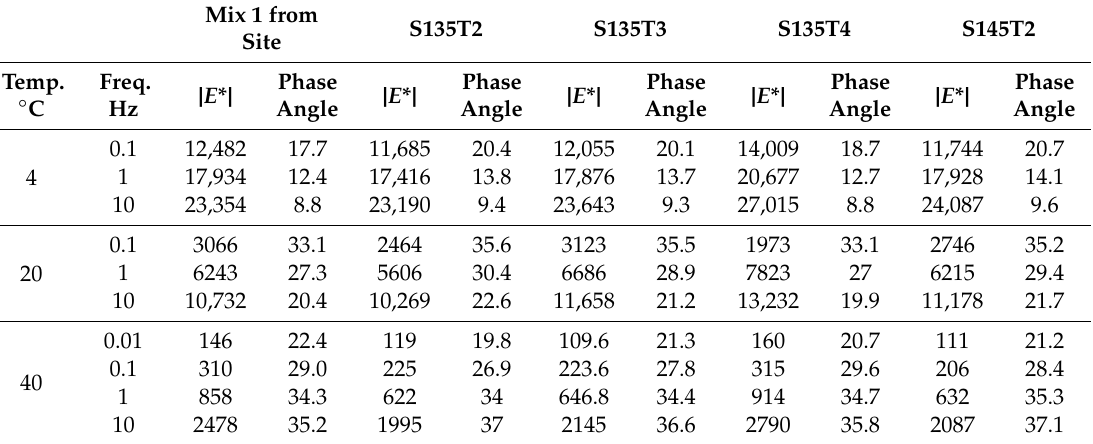
Table 3. Comparison of dynamic modulus results on mixture